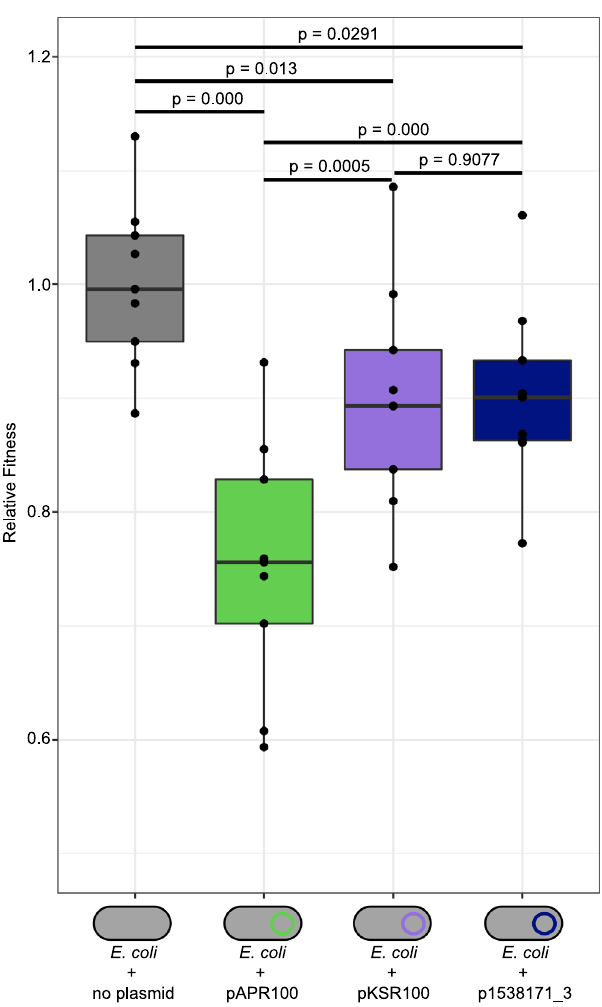
Fig. 4 | Relative fi tness of different Shigella MDR plasmids in E. coli . Relative fi tness of E. coli MG1655 carrying a previously characterised azithromycin resistance plasmid (pAPR100, green; pKSR100, purple), or p1538171_3 (navy) compared with a plasmid-free strain (grey). Each dataset is represented by a box and whisker plot indicating maximum and minimum values (upper and lower limits, respectively), and interquartile ranges (25th to 75th percentiles) of the original data, overlaid with black dots, indicating individual data points. The centre emboldened line on each box represents the median value. The results of pairwise statistical comparisons are shown above and with two-tailed p -values (two sample t-tests) indicated above black lines joining the pair comparators. The sample size for statistical purposes is n =3 biologically independent samples (see